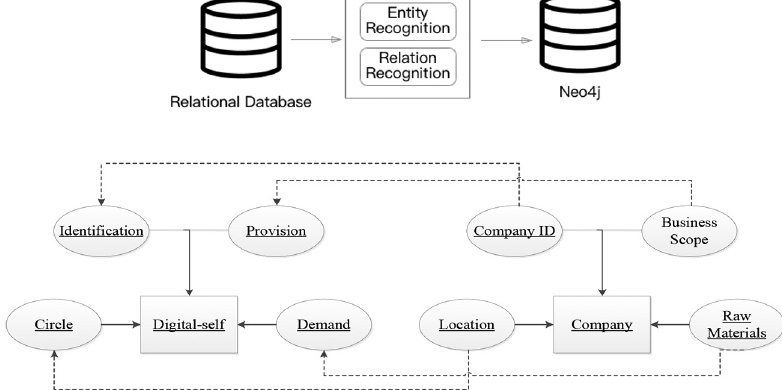
Figure 5. The dgital self ’ s attributes and the database